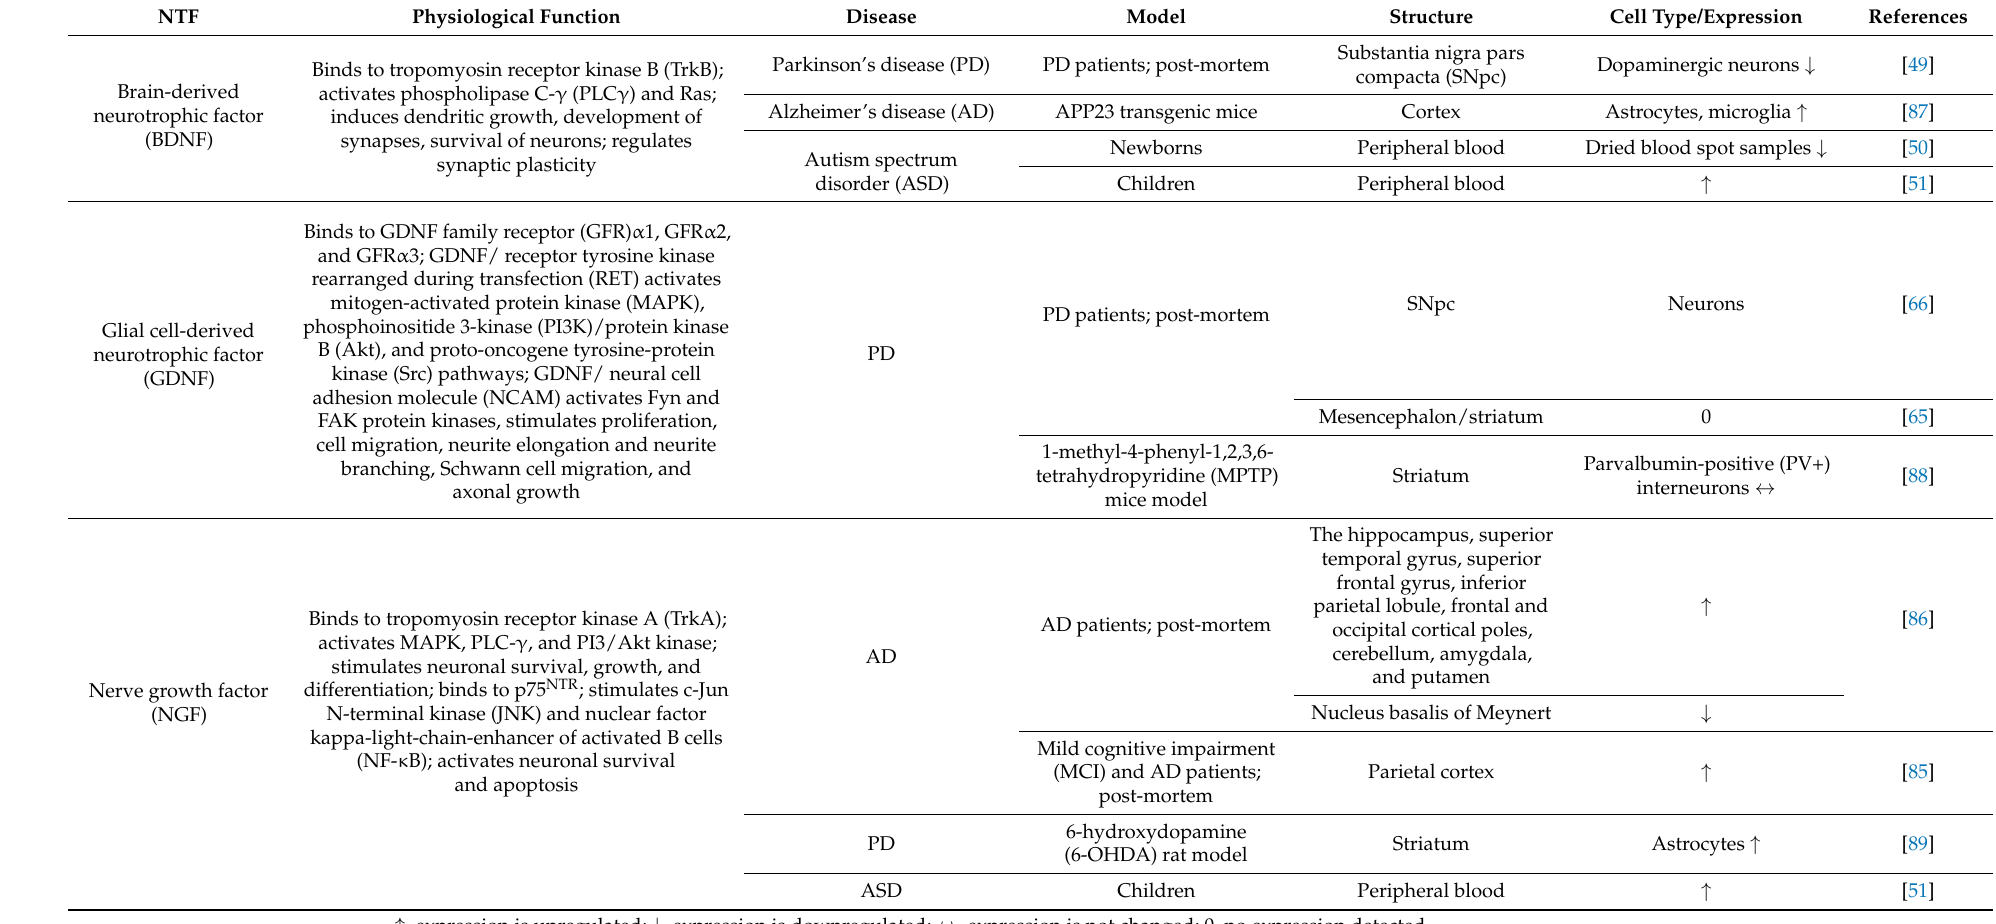
Table 1. Neurotrophic factors (NTFs) expression in central nervous system (CNS) disorders and disease